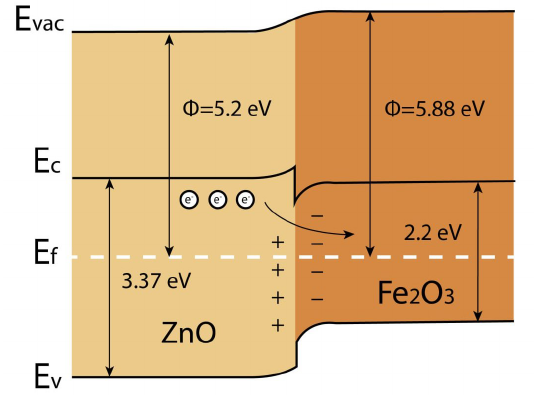
Figure 13. Energy diagram of heterojunction formation between ZnO and Fe 2 O 3 in ZnO/Fe 2 O 3 thin